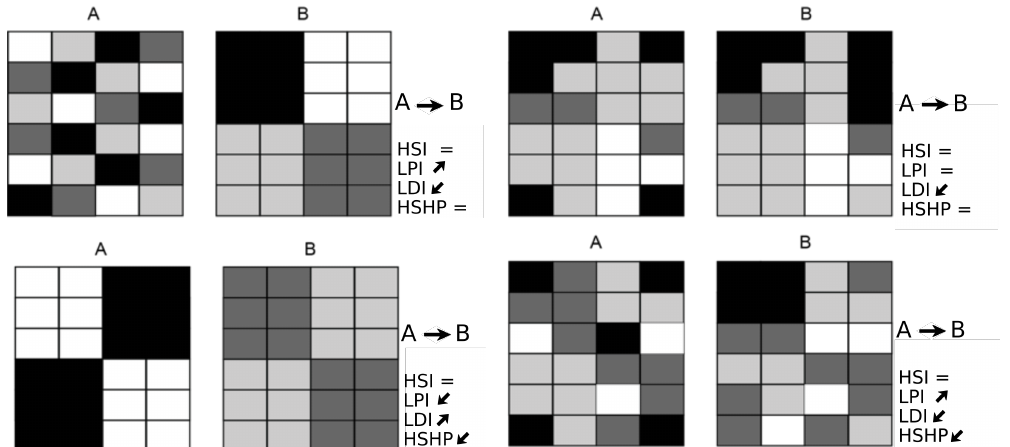
Figure 4. Example of the landscape evolution for a given HSI value and the dynamics of the landscape metrics. HSI, LPI, LDI, and HSHP correspond to the habitat suitability index, the largest patch index of a highly suitable habitat, the landscape division index, and the highly suitable habitat proportion, respectively. LPI, LDI, and HSHP were calculated for patches that were judged to be highly suitable (HSI ≥ 0.5) and are represented in